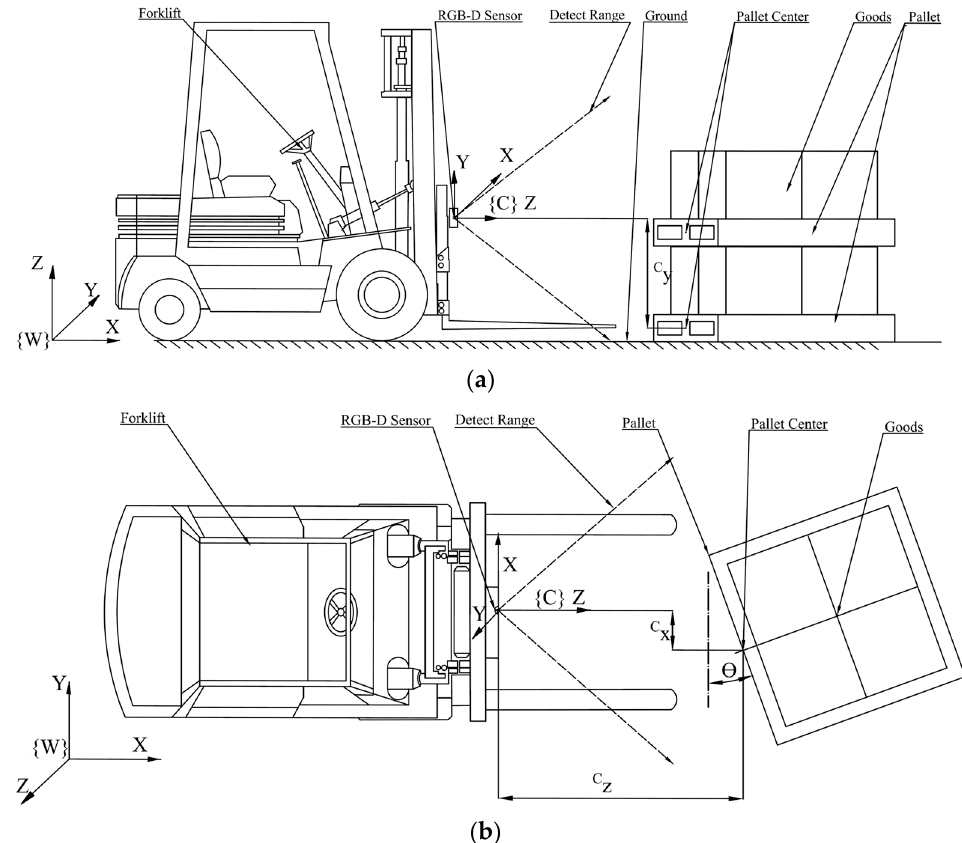
Figure 1. Schematic of forklift detection situation. (a) Side view schematic. (b) Overhead view schematic view